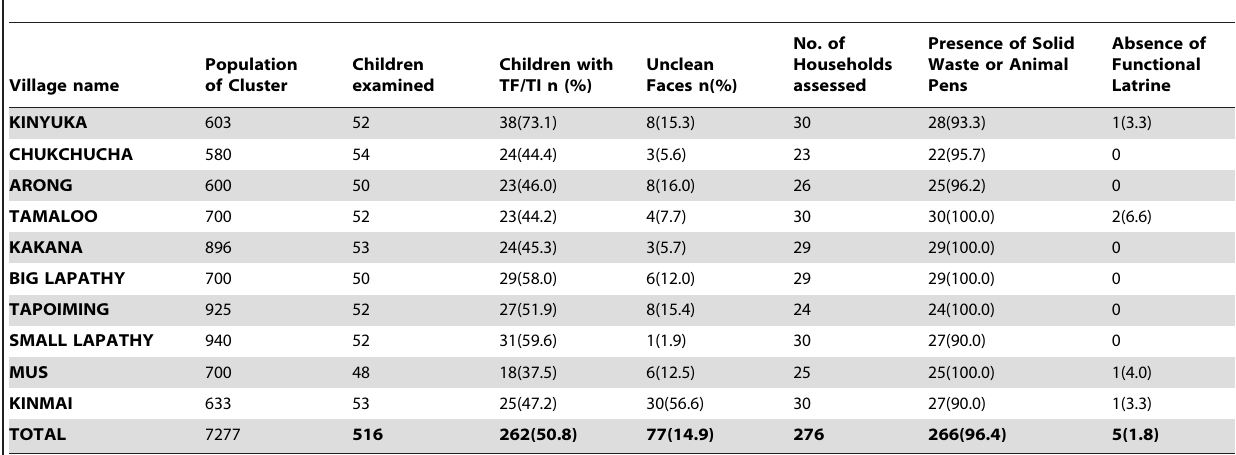
Table 1. Distribution of children with signs of active trachoma infection & its related risk factors in Car Nicobar Island.